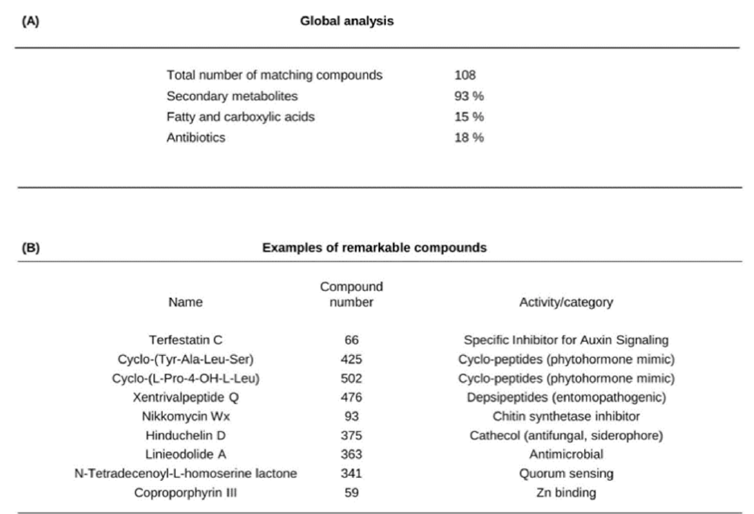
Figure 5. Summary of the metabolomics analysis. ( A ) Global analysis: Total number of matching compounds (from supplemental Table S2) and relative abundancy (% with respect to the total number of compounds) of selected categories of compounds. ( B ) List of selected remarkable compounds and putative activities (from Table S2).